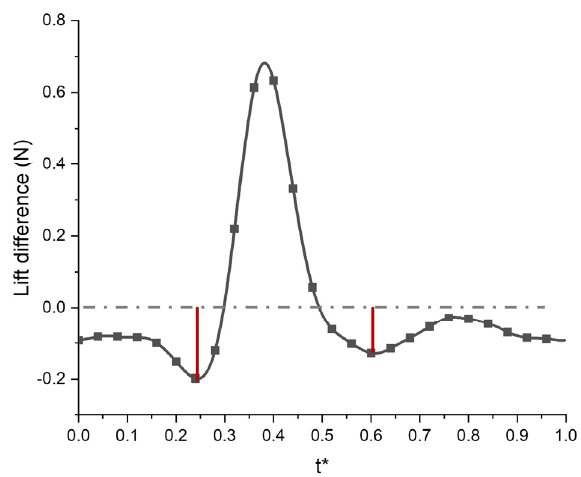
Figure 16. Lift difference of case 2.7 and 2.1.